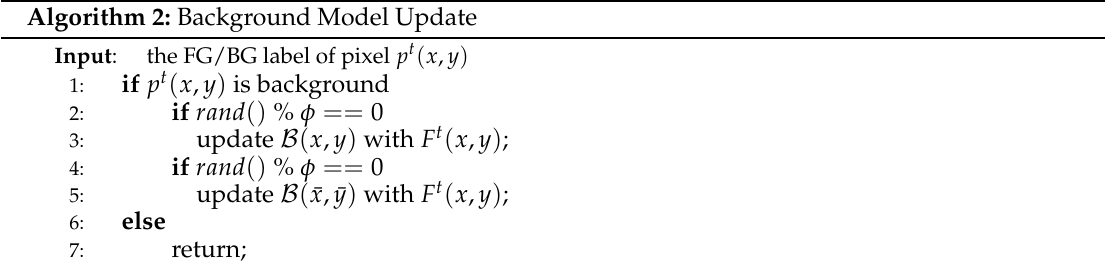
Algorithm 2: Background Model